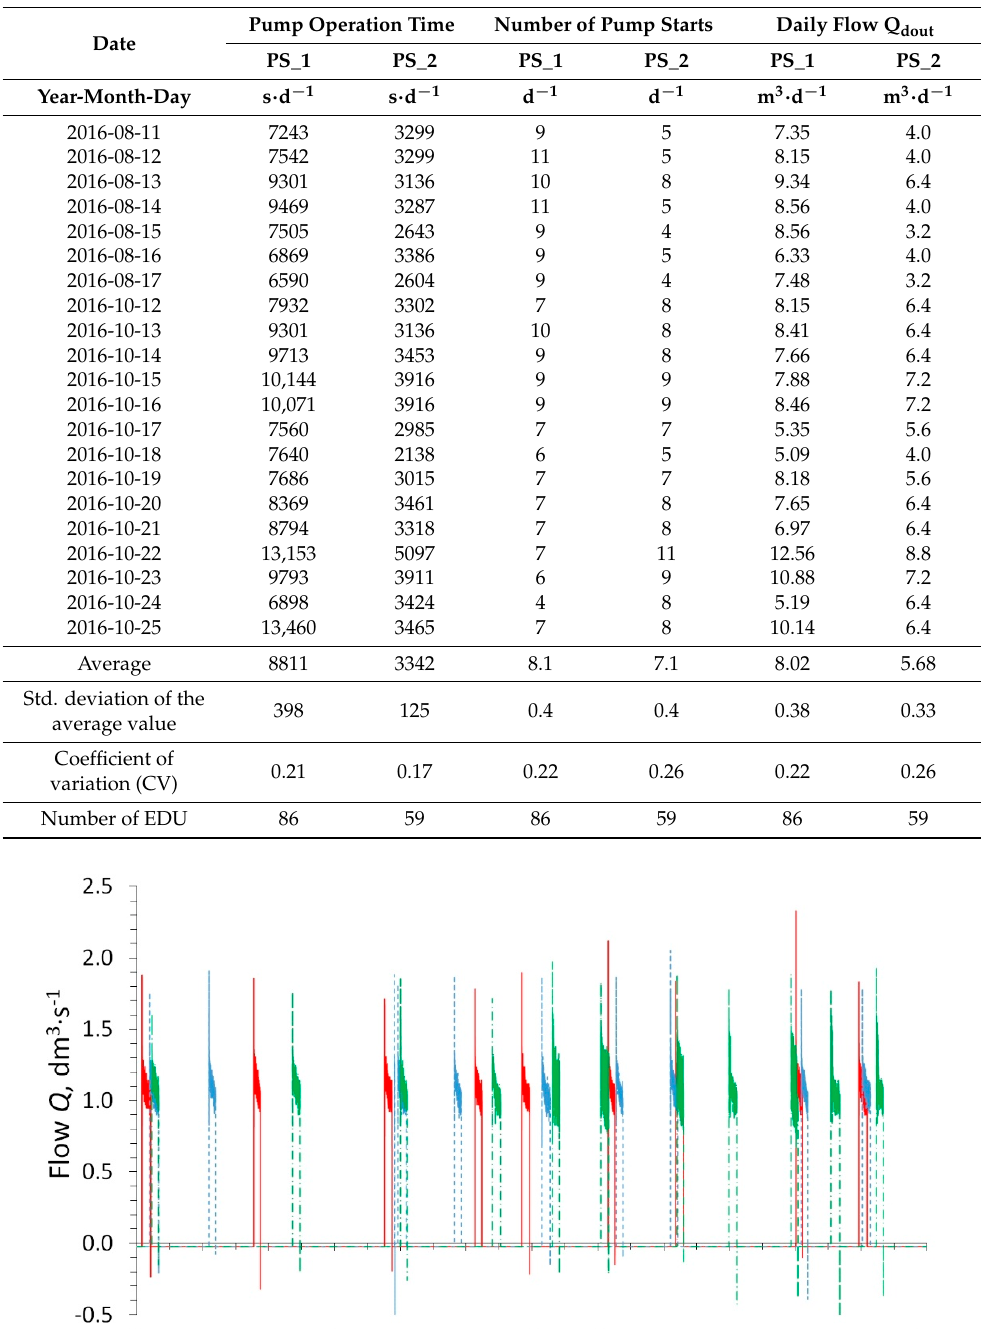
Table 3. Measured pumping station’s operational characteristics.